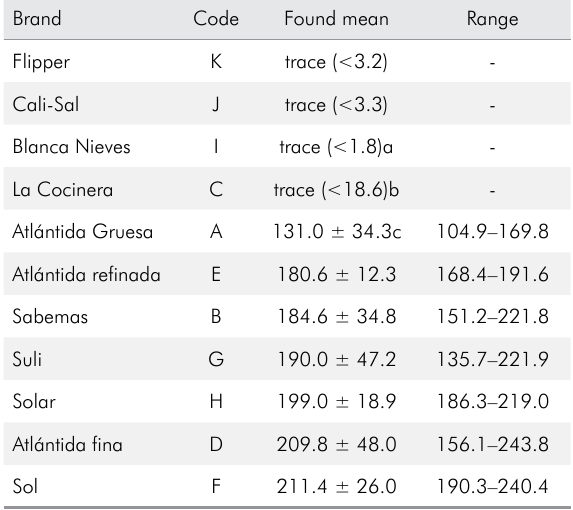
Table 3. Means and ranges of fluoride concentrations (mg/kg; n=3/brand) found in salt